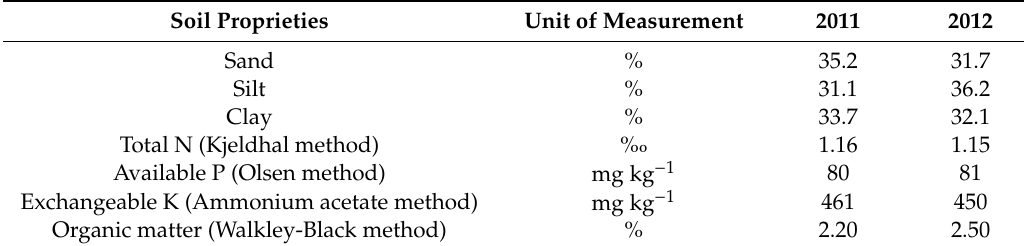
Table 1. Main soil physical and chemical properties relative to the two years under examination.